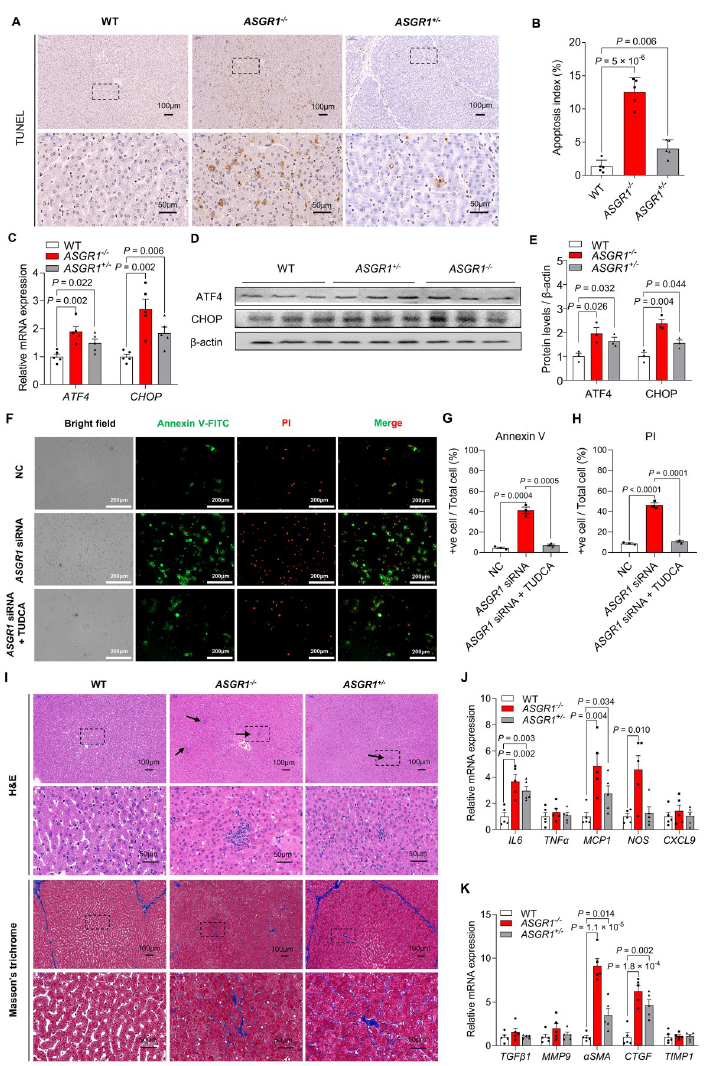
Fig 6. ASGR1-deficient pigs show liver injury. A, B. ( A ) Representative histological images of the TUNEL assay on liver tissue of 24-month-old WT and ASGR1-deficient pigs (Scale bars, 50 μ m, 100 μ m), ( B ) the apoptotic index quantification in livers of 24-month-old WT and ASGR1 -deficient pigs ( n = 5 per group, data represent two independent experiments combined). C. Relative mRNA expression of ER stress marker genes ATF4 and CHOP in livers of pigs ( n = 5 per group, data represent two independent experiments combined). D, E. Representative ( D ) Western blot analysis and ( E ) quantification of ATF4 and CHOP in the livers of pigs ( n = 3 per group, data are representative of two independent experiments). F. Representative the fluorescence microscopy images of HepG2 cells treated with vehicle, 100 nM ASGR1 -siRNA or 100 nM ASGR1 -siRNA plus 400 μ M TUDCA for 24 h, were stained with AV-FITC (green) and PI (red), and observed by confocal microscopy ( × 400). G, H. Quantification of the ( G ) AV-FITC positive cells and ( H ) PI positive nuclei compared with total HepG2 cells. Values are means ± SEM, ( n = 3 per group, data are representative of three independent experiments). I. H&E and Masson’s trichrome staining of liver sections from 24-month-old pigs fed a normal diet. H&E staining showing inflammation (arrow) and Masson’s trichrome staining of the distribution of collagen in blue demonstrated positive fibrosis in the livers of ASGR1-deficient pigs (Scale bars, 50 μ m, and 100 μ m). J , K. Relative mRNA expression of ( J ) inflammation and ( K ) fibrosis-related markers in livers of ASGR1-deficient pigs and WT controls ( n = 5 per group, data represent two independent experiments combined). P values are shown for indicated comparisons were analyzed using ordinary one-way ANOVA followed by Tukey’s test. Values are mean ± SEM. Points indicate data from individual pigs. The underlying data for this figure can be found in S1 Data . ANOVA, analysis of variance; ATF4, Activating Transcription Factor 4; AV-FITC, Apoptosis determined by Annexin V fluorescein isothiocyanate; CHOP, C/EBP homologous protein; ER, Endoplasmic reticulum; H&E, hematoxylin-eosin; PI, propidium iodide; TUDCA, tauroursodeoxycholic acid; TUNEL, terminal deoxynucleotidyl transferase dUTP nick end labeling; WT, wild-type.